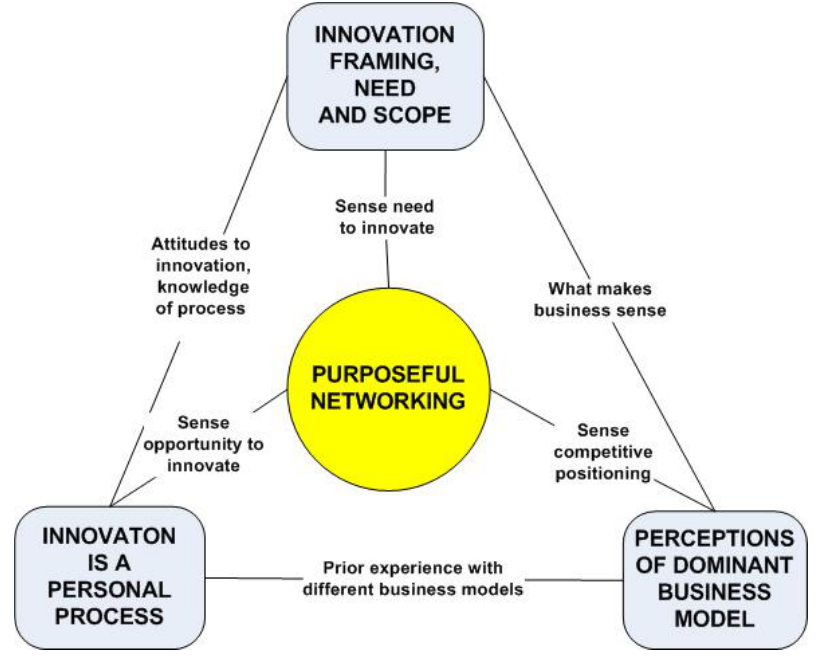
Fig. 2. Conceptual Framework for the